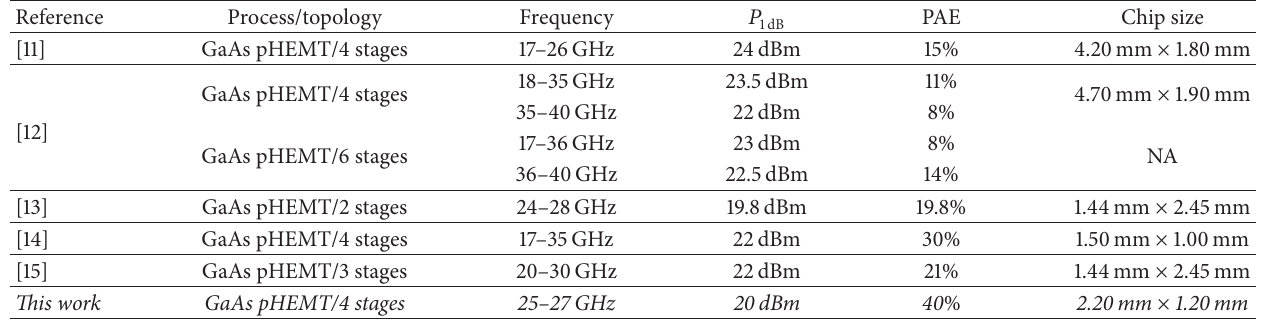
Table 2: The efficiency comparison of K-band PAs.